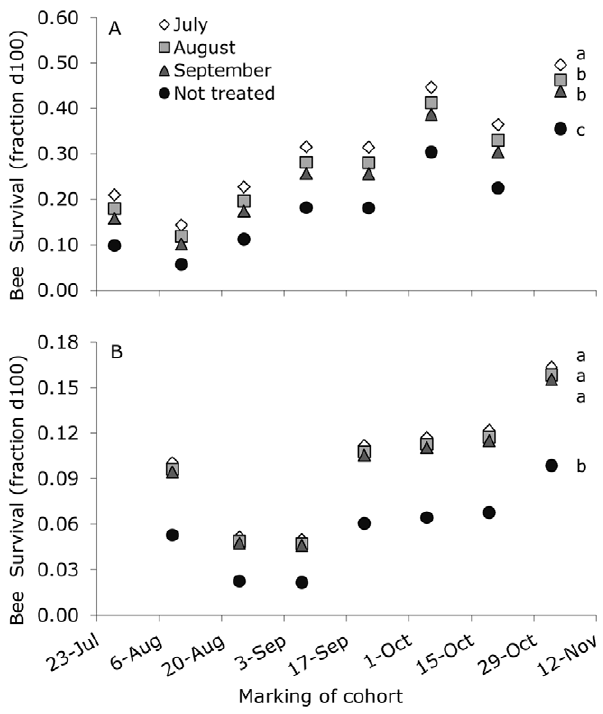
Figure 3. Mean daily mite fall in 2005/2006 (A) and 2006/2007 (B). Colonies were treated with Thymovar H in July (white bars), August (grey bars), September (dark grey bars), or not treated at all (black bars). All colonies were treated in December using oxalic acid (3%). Letters denote significant differences between treatments within each month. No letters mean no significant differences between treatments were found. Differences between months were not given.